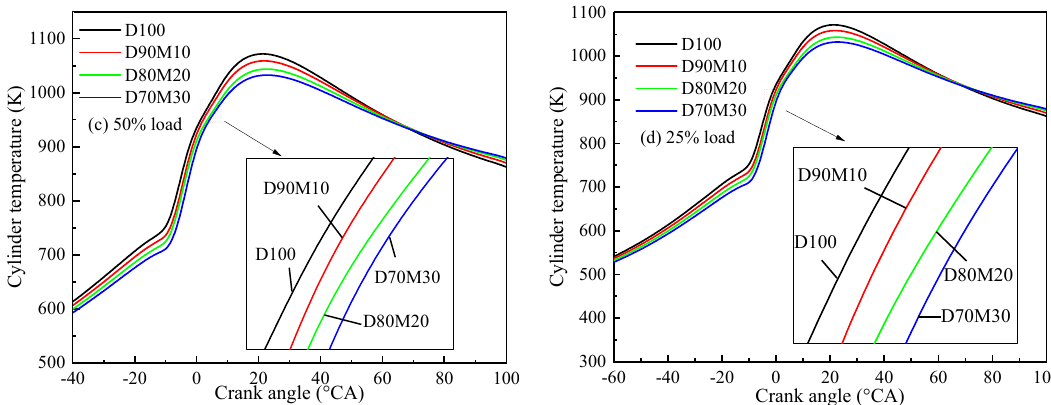
Figure 8. Heat release rate curves of different proportions of diesel–methanol blended fuel under different load conditions. ( a ) at 100% load, ( b ) at 75% load, ( c ) at 50% load, ( d ) at 25% load.